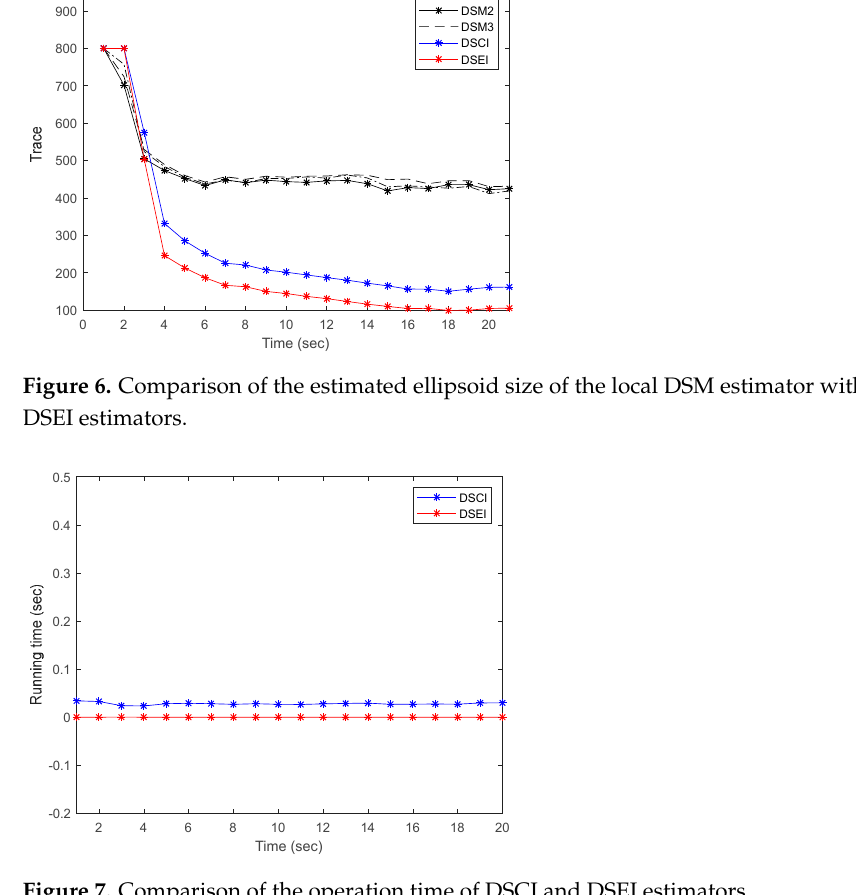
Figure 7. Comparison of the operation time of DSCI and DSEI estimators.